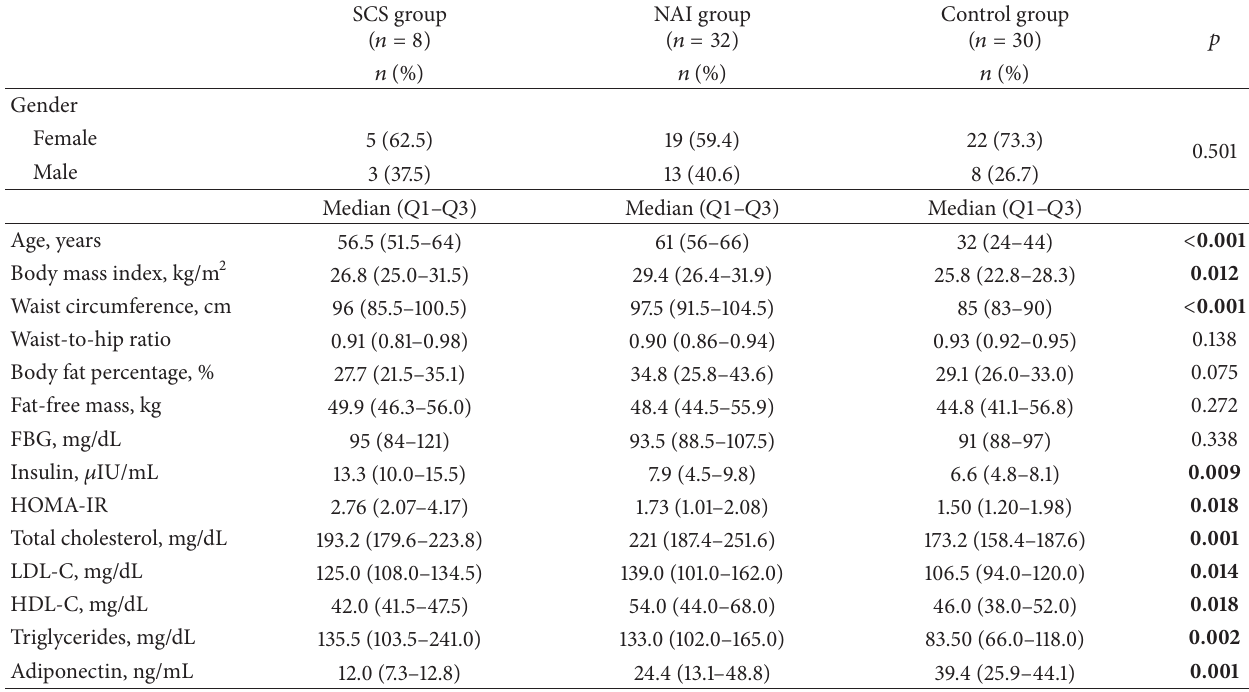
Table 3: Demographic, clinical, and metabolic characteristics of the study groups.